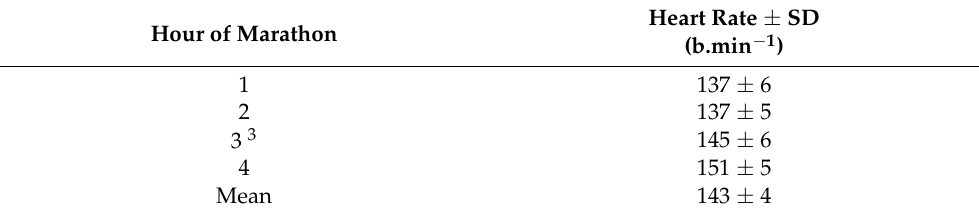
Table 3. Average heart rate per hour of marathon for all 10